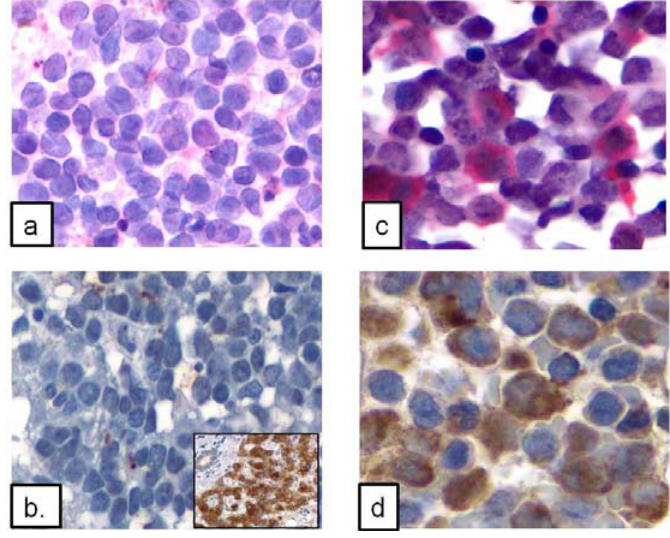
Figure 3. Representative CYP2E1 protein expression shown by immunohistochemistry in leukemic cells of AML with inv(16) and AML without inv(16) as a control. ( a , b ) Low level or absent CYP2E1 expression in two different cases of AML without inv(16) (hematoxylin & eosin, 400  ); Inset ( b ) CYP2E1 expression in normal human liver tissue as a control; ( c , d ) Strong CYP2E1 expression in two different cases of AML with inv(16) (500×). In ( a , c ), new fuschsin was used with alkaline phosphatase; whereas in ( b , d ) DAB was used with horseradish